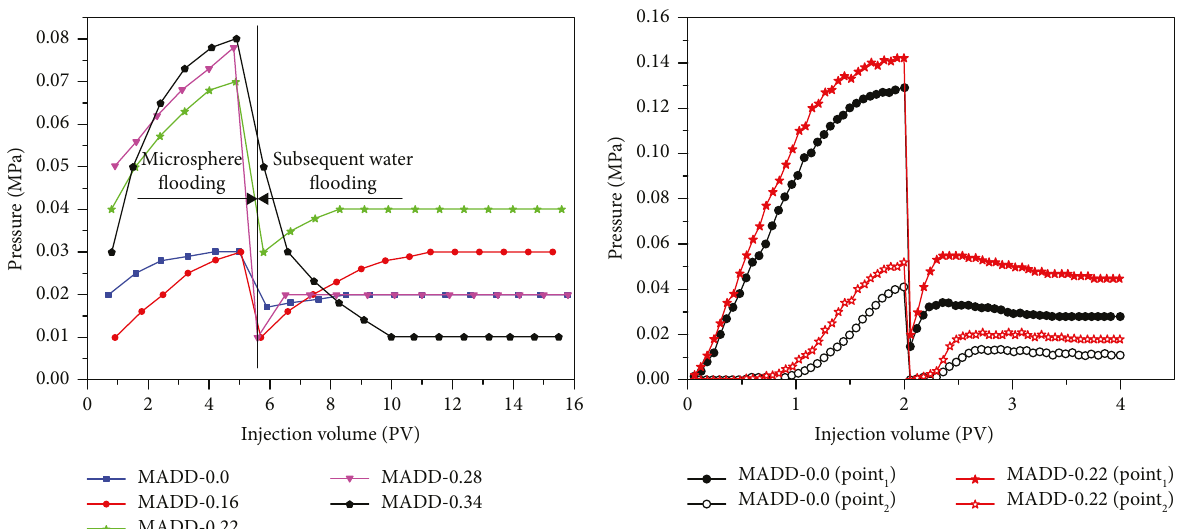
Figure 12: Variation of the injection pressures during the injection of the 3000mg/L microsphere solution at 45.0 ± 0.1 ° C. Table 5: Blocking e ffi ciency of microspheres in the cores.